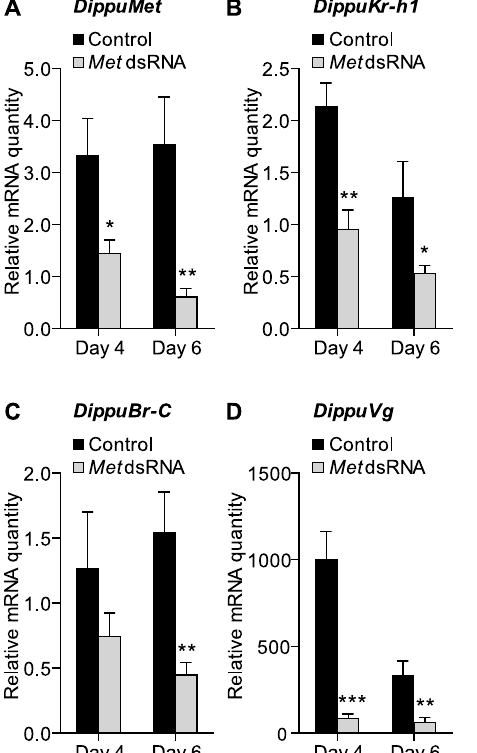
Figure 3. Knockdown of DippuMet by RNAi results in significant downregulation of DippuMet (A) DippuKr-h1 (B), DippuBr-C (C) and DippuVg (D). Measurements were taken from the fat body on days 4 and 6 of the first gonadotropic cycle. Data points represent the mean of 7–8 individual animals, (n=7–8) and three technical replicates, normalized to Tub and EF1 a . Vertical error bars indicate SEM.